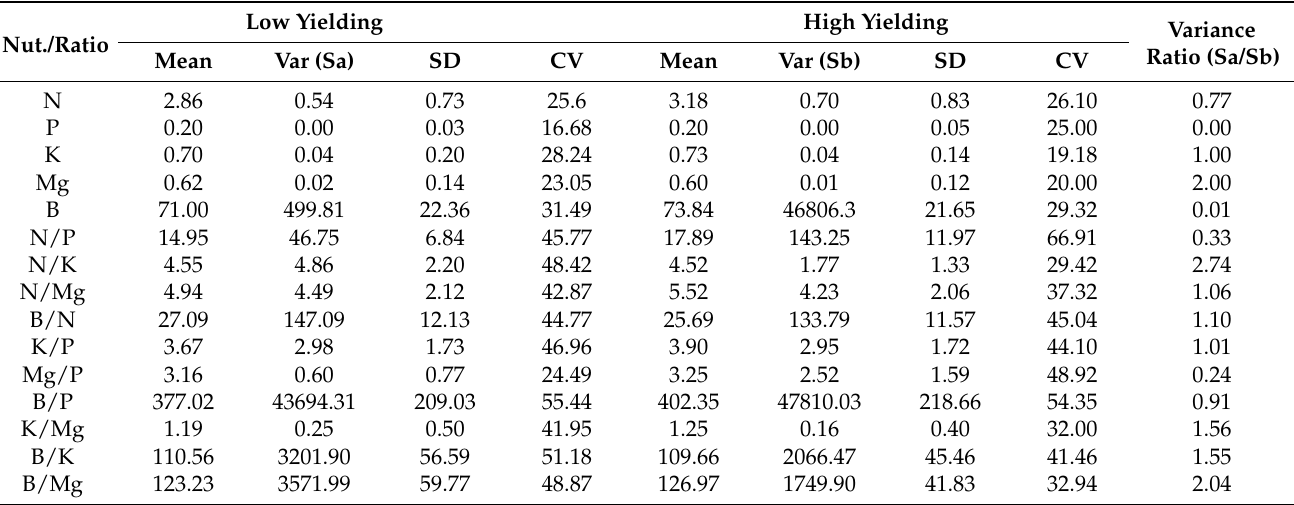
Table 1. Mean values of nutrient expressions and their descriptive parameters * of low and high yielding populations (n =